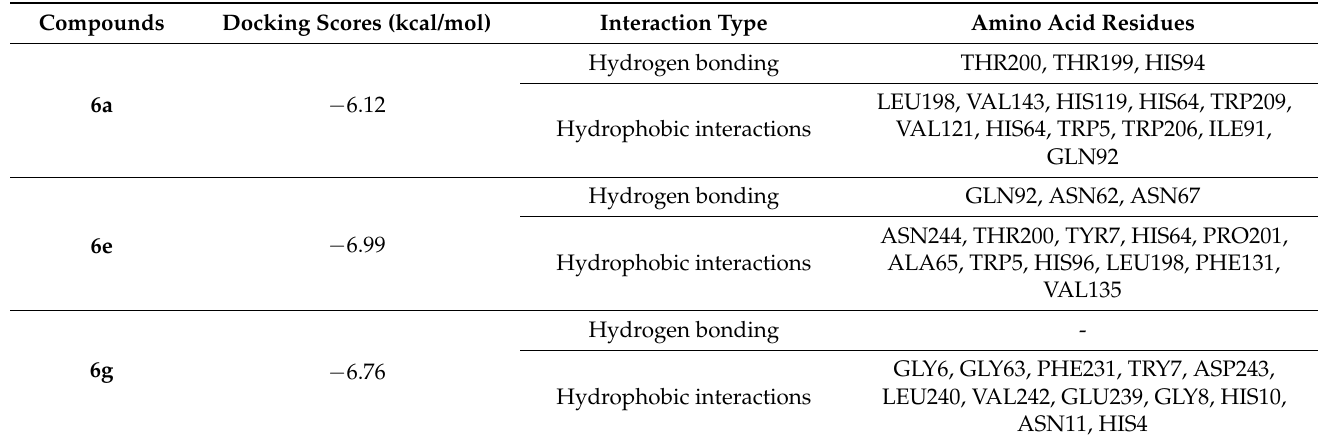
Figure 6. An illustration representing generated pharmacophore features of compound 6e based on brinzolamide inhibitor. Pharmacophoric features included hydrogen bond acceptors (blue spheres), aromatic (orange spheres), and hydrophobic features (green spheres). Table 4. Docking scores and molecular interactions of compound 6a, 6e , and 6g